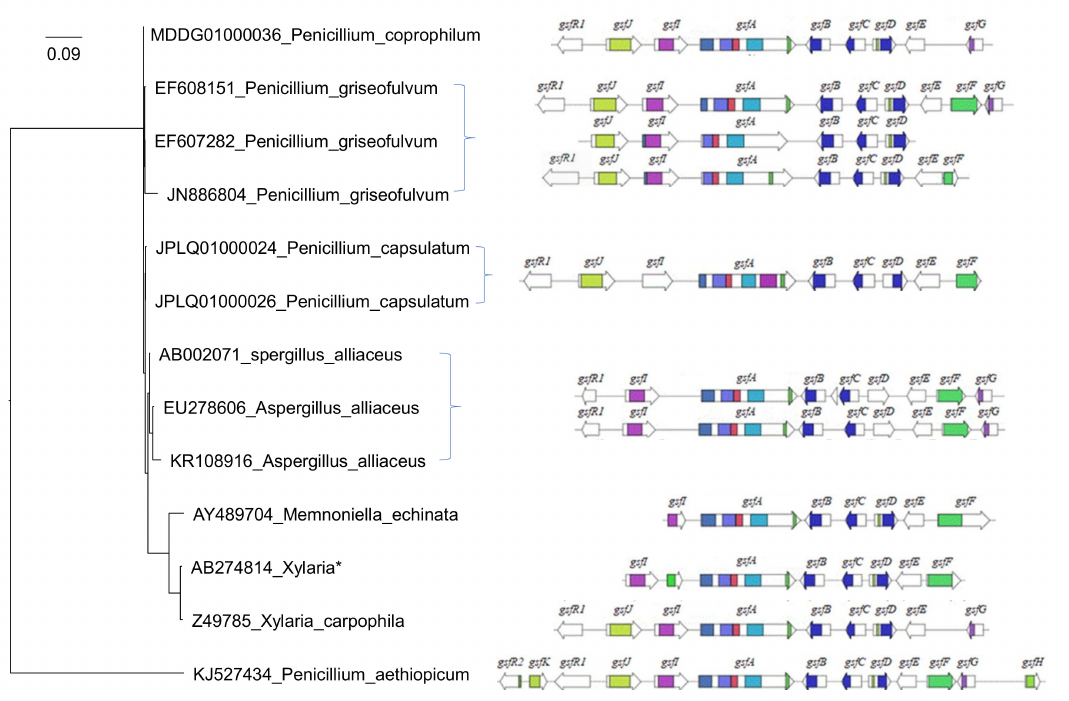
Figure 1. Griseofulvin biosynthetic gene cluster in P. aethiopicum and other fungal species The arrows show the gsf gene candidates and their orientations in griseofulvin biosynthesis gene cluster. The phylogenetic tree is reconstructed with 18S rRNA sequences (in the format of accession_species) with the PhyML software after alignment with MAFFT. The gsf genes for Xlaria* is X. flabelliformis which does not have an 18S rRNA sequence. X. angulosa was used instead. P. aethiopicum has only 33 nt of the 18S rRNA in contrast to other sequences that are ~1700 nt